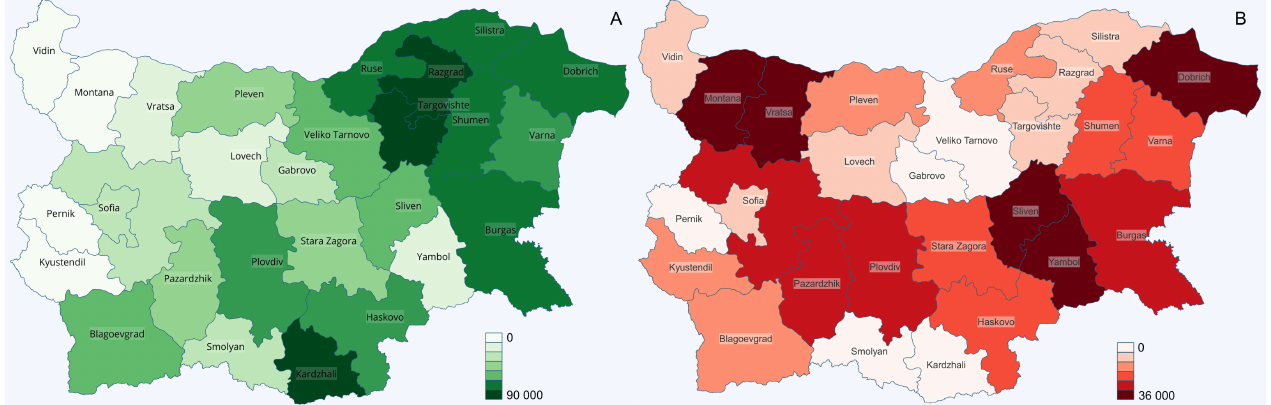
Figure 2. Ethnic maps of Bulgaria: ( A ) administrative districts and numbers of Turkish population; ( B ) administrative districts and numbers of Gypsy population.